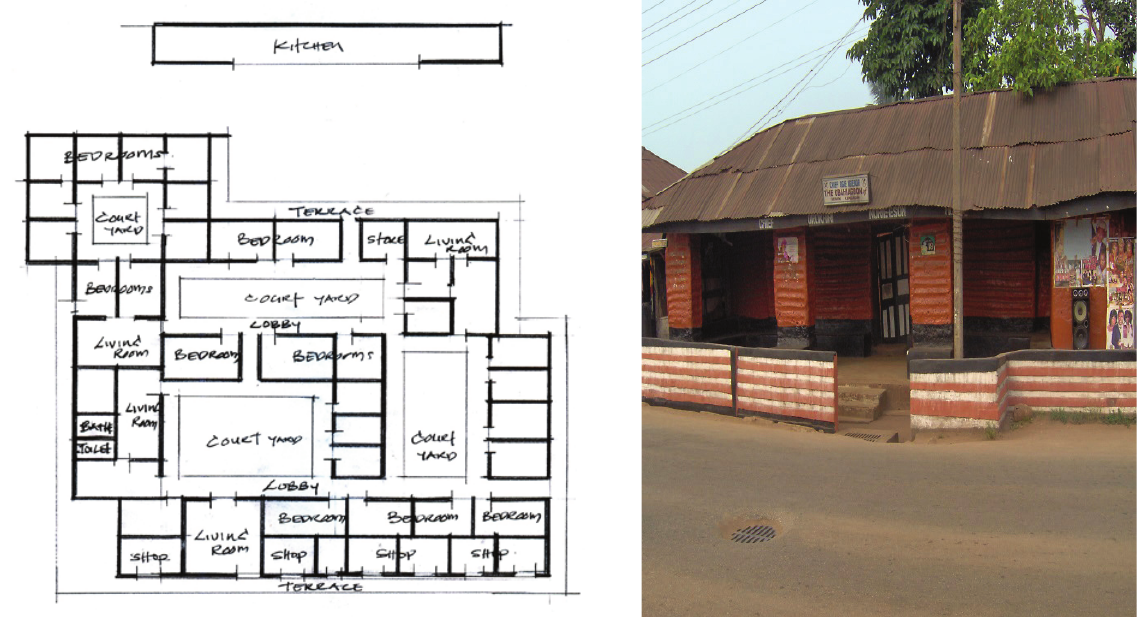
Fig. 4. Floor plan and picture of a typical family-compound Benin house Source: Ekhaese